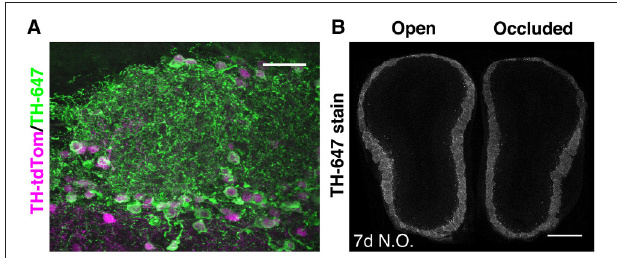
FIGURE 1 | Pronounced but ongoing loss of OB DA neurons after 7 days of naris occlusion. (A) TH staining of the GL in a TH-tdTom mouse. Scale bar: 30 µ m. (B) TH staining in a coronal section through both OBs of a naris-occluded mouse. Mean fluorescence intensity in the GL was 26.7% lower in the occluded than in the open OB. Scale bar: 500 µ m.